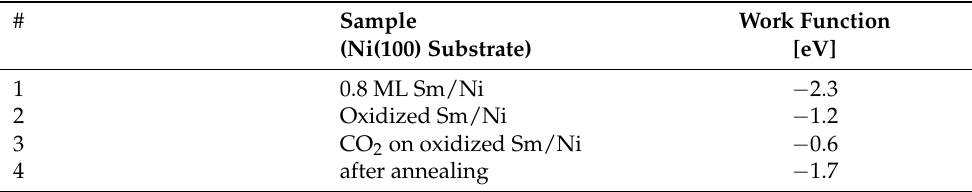
Table 2. Work function values relative to Ni(100) for the following samples: (1) sample of effective Sm coverage of 0.8 ML on Ni(100); (2) sample 1 oxidized by 10 L O 2 at a temperature of 300 K; (3) sample 2 exposed to 1 L CO 2 at 130 K; (4) sample 3 after annealing to 900 K. The work function of